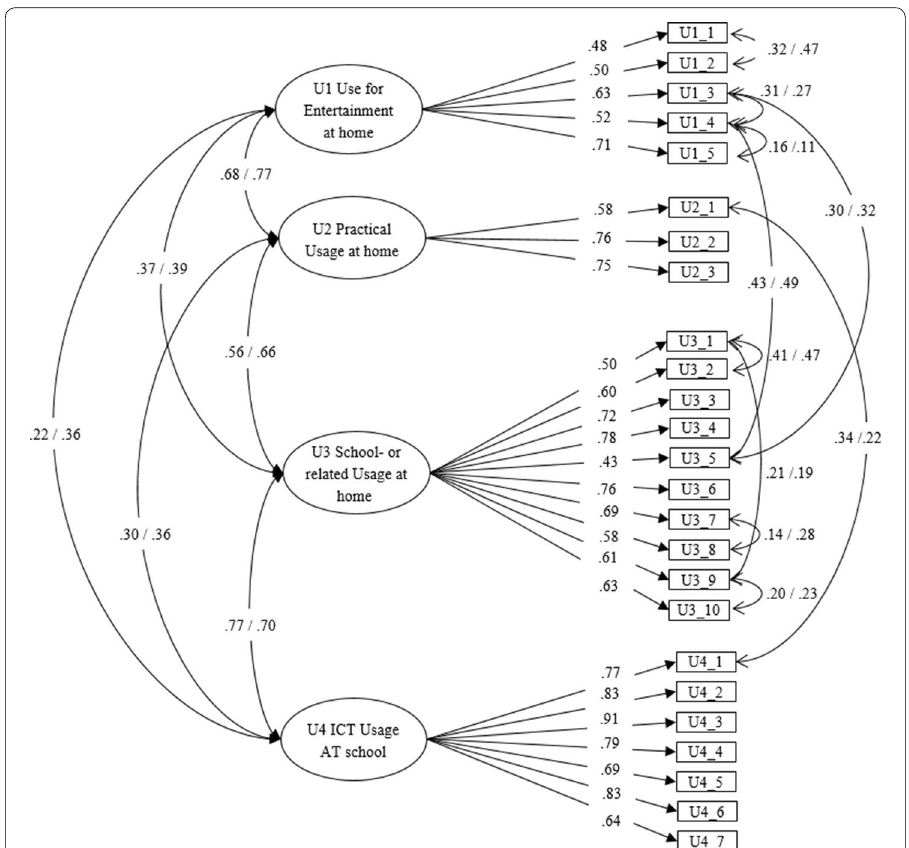
Fig. 2 Measurement model for ICT Usage. Values in front of the forward slash refer to values for the Swiss sample, whereas the values after the forward slash refer to the results for the German sample. The presented results are based on the scalar SEM with fixed factor loadings and thresholds (Model fit: χ 2 CFI 0.938; RMSEA = =